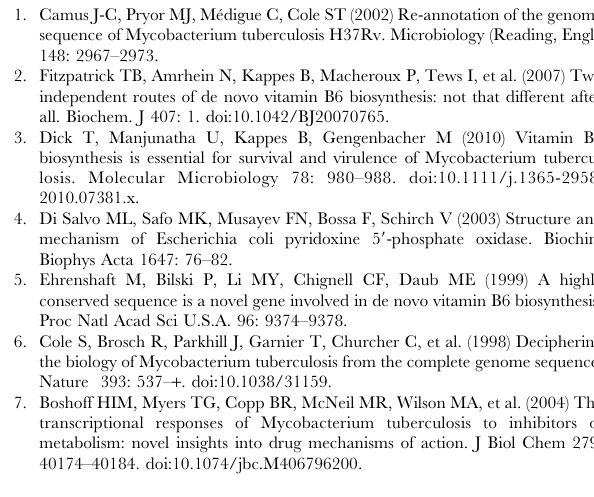
Figure S2 MS/MS spectra of Rv2607 homodimer. The isolated precursor ion, charge state 14 + of the dimeric Rv2607 complex was submitted to CID with accelerating voltages 150 V (Trap) and 110 V (Transfer). Low populations of charge-state series A and B corresponding to monomers with measured masses 27362 Da (monomer, high m/z region) and 27353 Da (low m/z region) begins to occur at these high voltages. High accelerating voltages also caused fragmentation of the protein, indicated by a few unassigned peaks at the low and high m/z region. (TIF) Figure S3 Protein sequence alignment of Rv2607 and E. coli PNPOx. Residues highlighted in red are highly conserved motifs in PNPOxs [25]. The arrow points to a key difference in the E. coli PNPOx and Rv2607 sequence that results in greater solvent- exposure of the active site in Rv2607. (TIF) Figure S4 Structural and mechanistic analysis of Rv2607- catlyzed oxidation of PNP to PLP. (A) Superimposition of the active site residues of Rv2607 (yellow, PDB ID: 2A2J) and E. coli PNPOx (grey, PDB ID: 1G77). Labeled residues correspond to Rv2607. PLP and FMN are present in the E. coli PNPOx structure only. (B) Proposed mechanism for the oxidation of PNP. A hydride is transferred from PNP to FMN and oxidized FMN is regenerated with molecular oxygen.